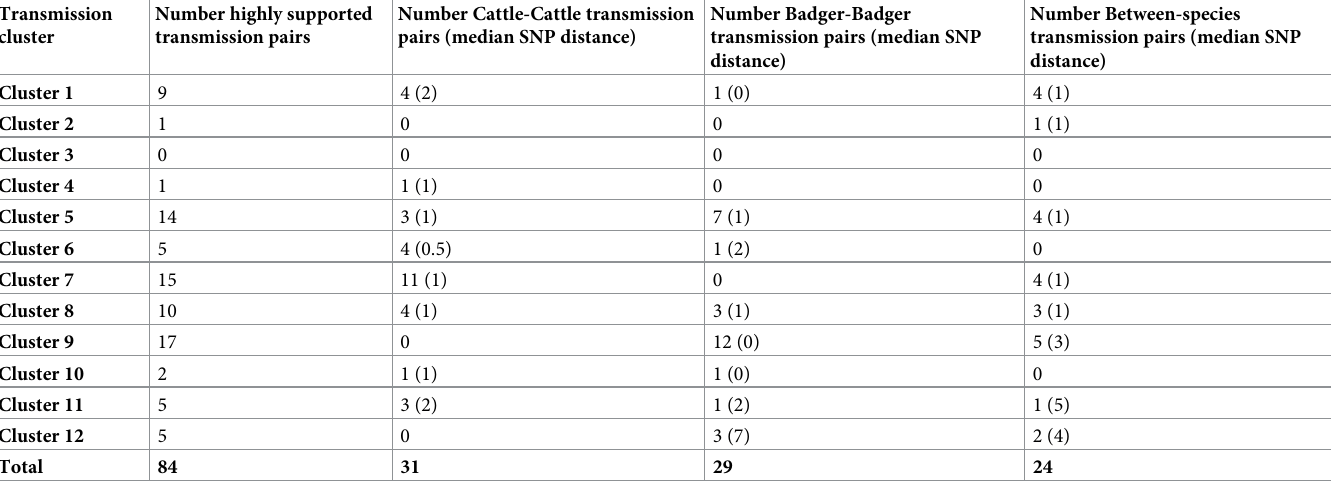
Table 3. Highly supported transmission pairs within each transmission cluster calculated using TransPhylo. For each transmission cluster, the number of intra- and inter-species transmission pairs with a probability > 0.5 is listed. The median SNP distance for each set of transmission pairs is given in parentheses. Transmission Number highly supported Number Cattle-Cattle transmission Number Badger-Badger Number Between-species cluster transmission pairs pairs (median SNP distance) transmission pairs (median SNP transmission pairs (median SNP distance)